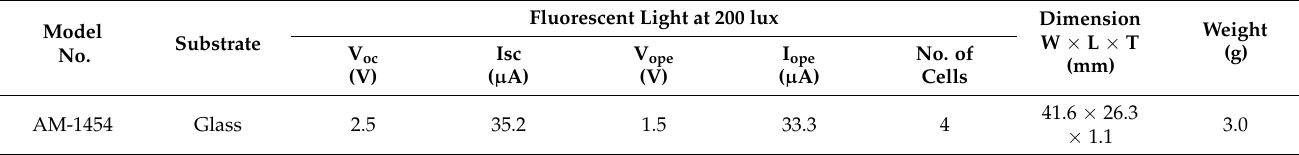
Figure 6. ( a ) AM-1454 solar PV module; ( b ) GM250-71-14-16 TEG module; ( c ) schematic structure of TEG module; ( d ) SHTC3 temperature and humidity sensor; ( e ) SEN0193 V1.2 capacitive soil moisture sensor. Table 4. Specification of solar PV module AM-1454.